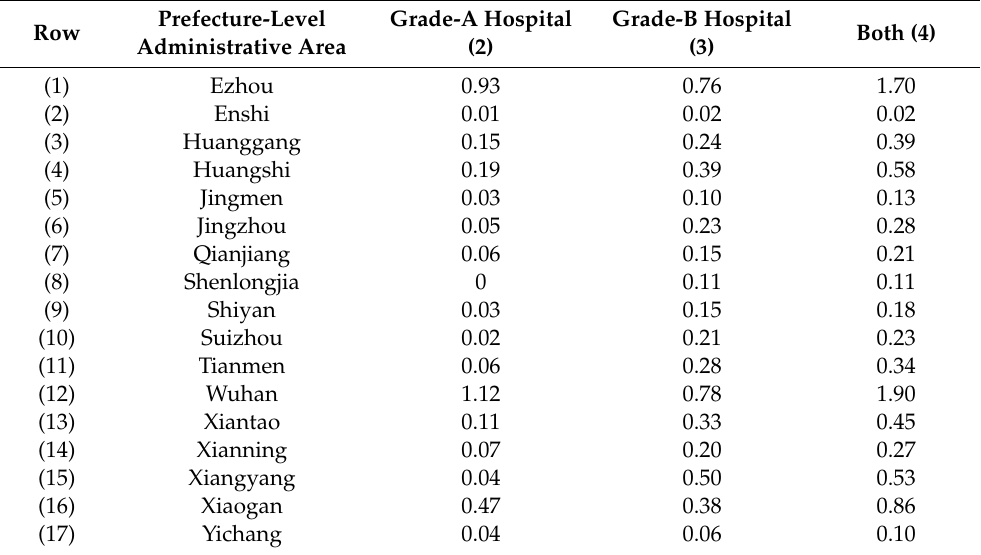
Table 3. Descriptive statistics of mean accessibility ratios at the prefecture level and hospital level.